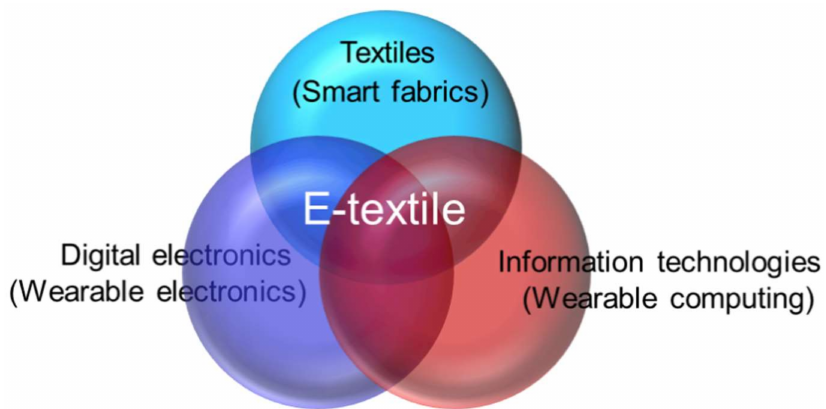
Figure 1. Multidisciplinary approach to